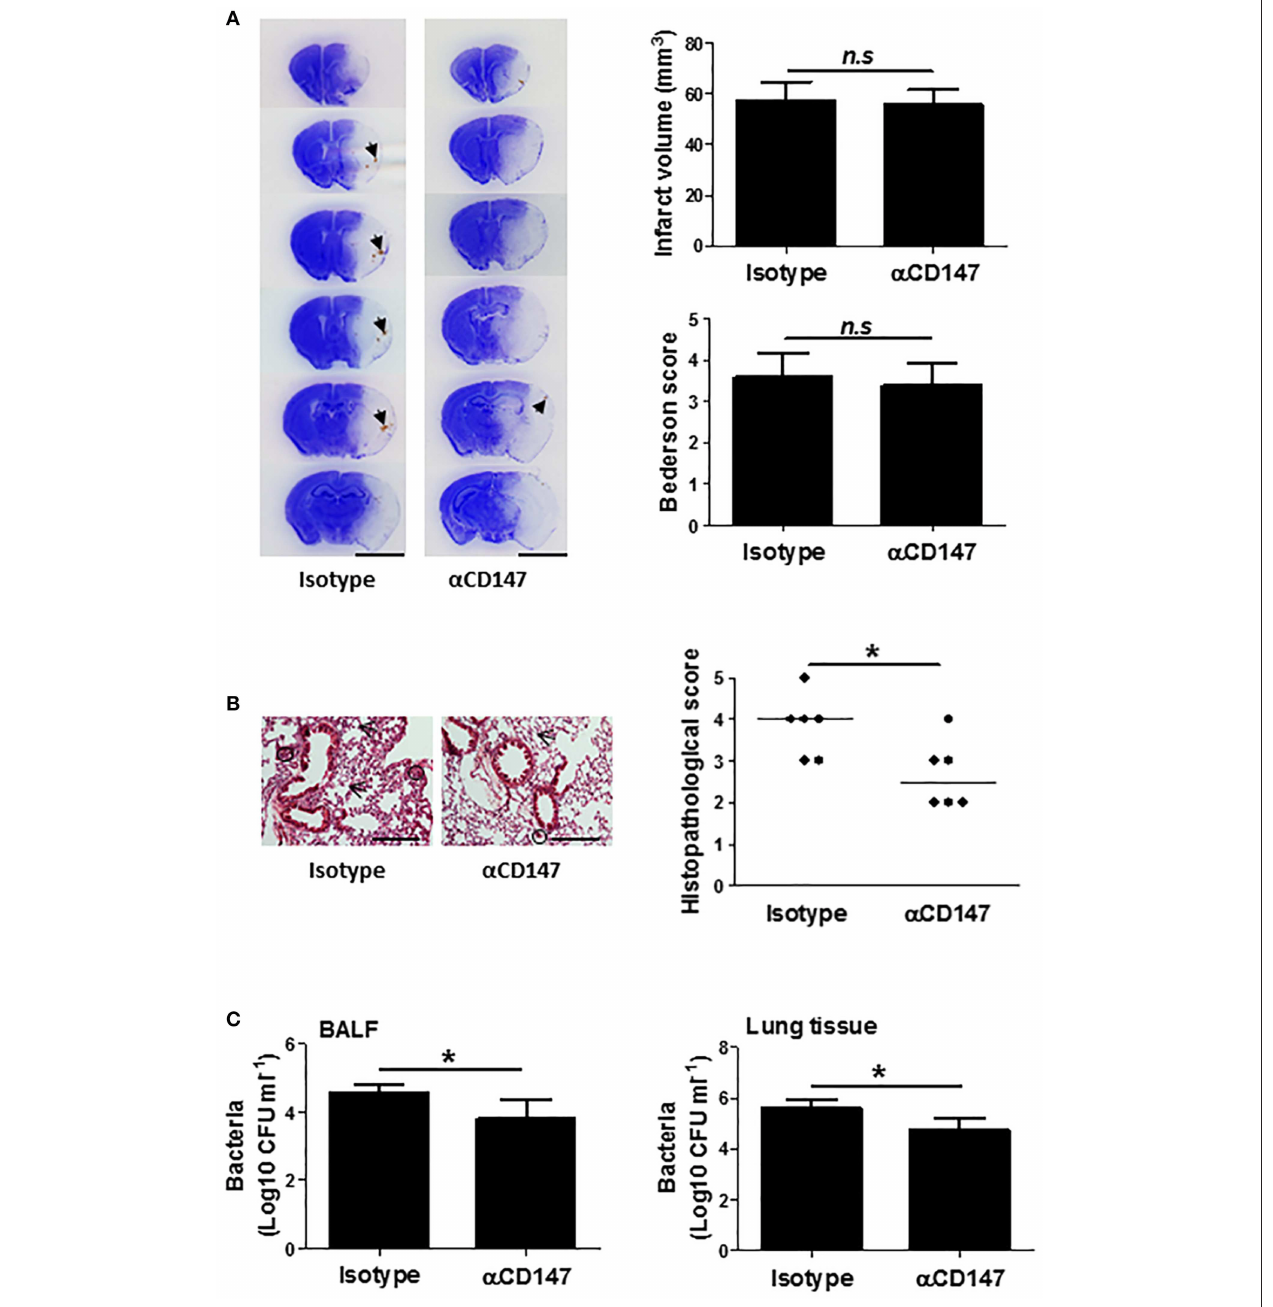
FIGURE 7 | Delayed inhibition of CD147 does not affect brain injury, but attenuates post-stroke lung damage. (A) Representative images of cresyl violet-stained brain coronal sections of mice (left panel). Blue color: intact tissues, white color: infarct tissues. Arrows indicate spontaneous hemorrhagic transformation. Bar = 5mm. Infarct volume and Neurological deficits (Right panel). n = 6 per group, n.s. indicates not statistically significant. (B) Representative images of hematoxylin and eosin-stained lung sections (Left panel). Black circles indicate the patchy areas of cellular consolidation. Arrows indicate the intra-alveolar infiltrates. Bar = 200 µ m. Quantitative analysis of histopathological lung injury scores (Right panel). Bars are median values. n = 6 per group. (C) Quantitative analysis of bacterial loads by measuring colony-forming units (CFU) in BLAF (left panel) and lung tissue homogenate (right panel) cultures in indicated groups at 3 days after stroke. n = 6 per group. * P <